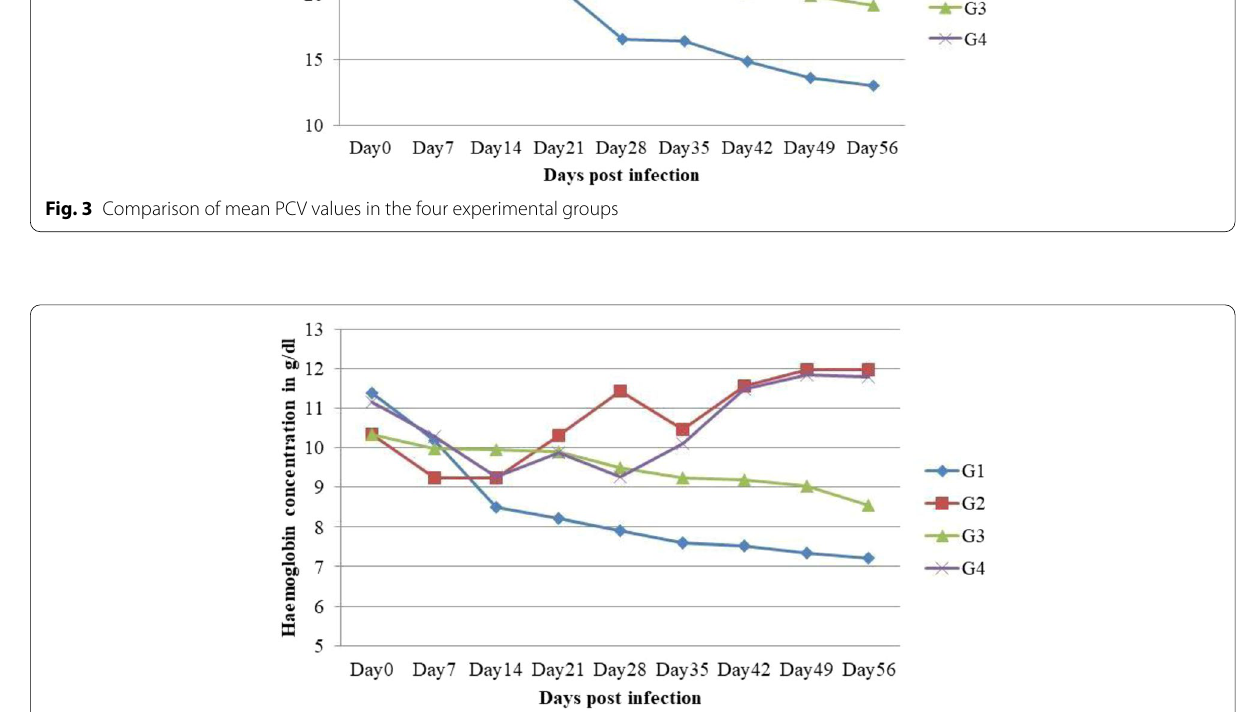
Fig. 4 Mean haemoglobin concentration in infected and control goat and